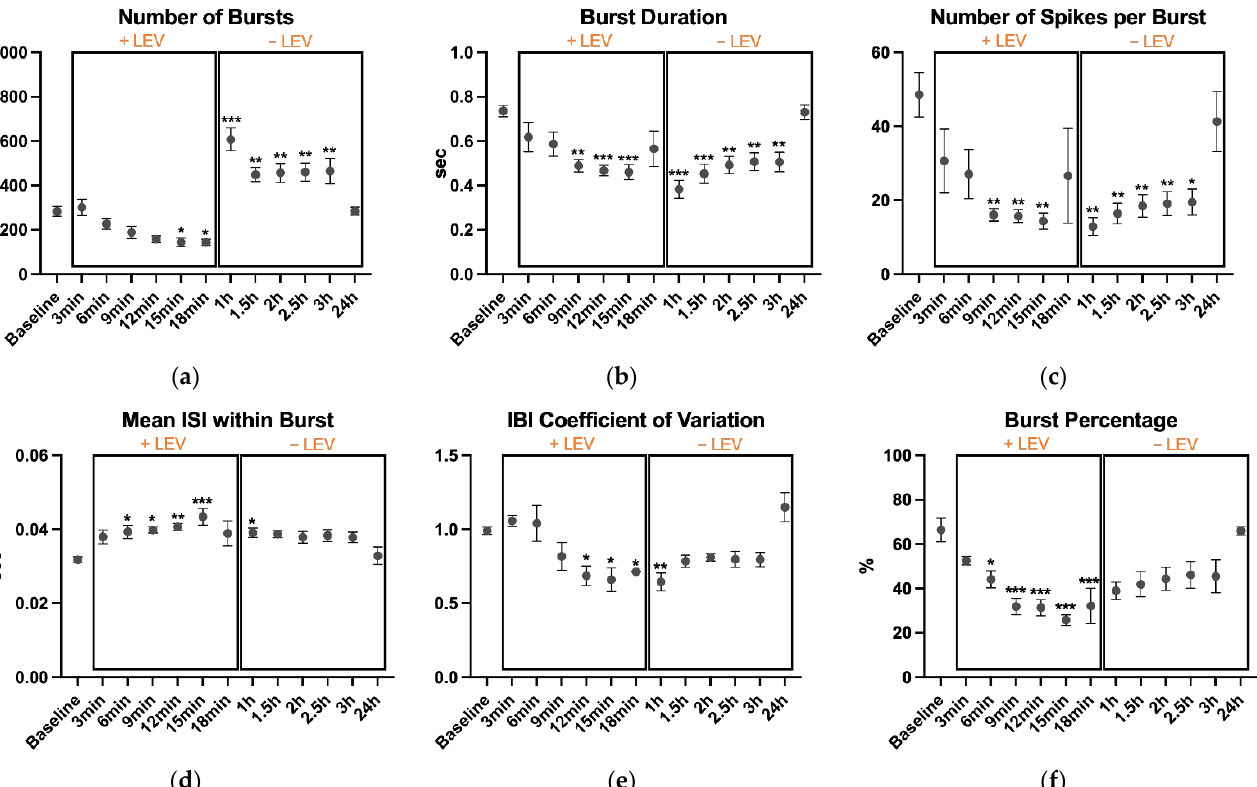
Figure 3. Single-electrode bursting results: ( a ) the number of bursts, ( b ) burst duration, ( c ) number of spikes per burst, ( d ) mean inter-spike interval within burst, ( e ) inter-burst interval coefficient of variation, and ( f ) burst percentage during the 2 min recordings. After the baseline recording, LEV was added to the cell culture and its effects were monitored every 3 min up to 18 min; then, cell medium was replaced to remove LEV and cell activity was monitored every 30 min up to 3 h and finally, one recording was performed at 24 h. The cultures were kept at 37 °C under a 5% CO 2 atmosphere during the recordings. Data are expressed as mean ± SEM of four independent experiments. All comparisons are performed vs. the baseline. * p < 0.05; ** p < 0.01; *** p <